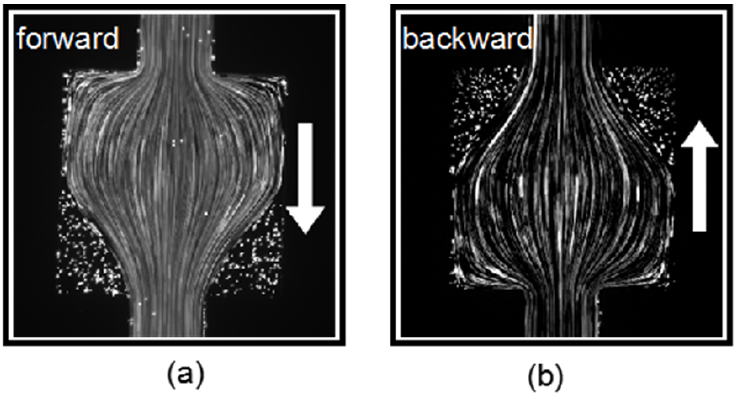
Figure 4. Viscoelastic flow pattern in the square chamber for flow along ( a ) the forward direction and ( b ) the backward direction at Wi = 5.56.